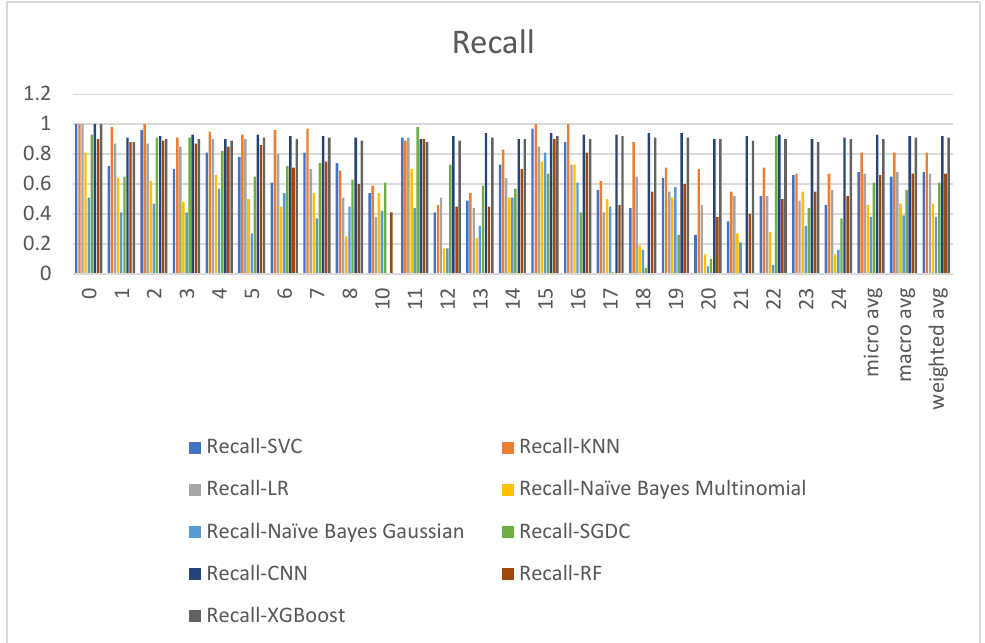
Figure 5. Recall. Figure 5. Recall.